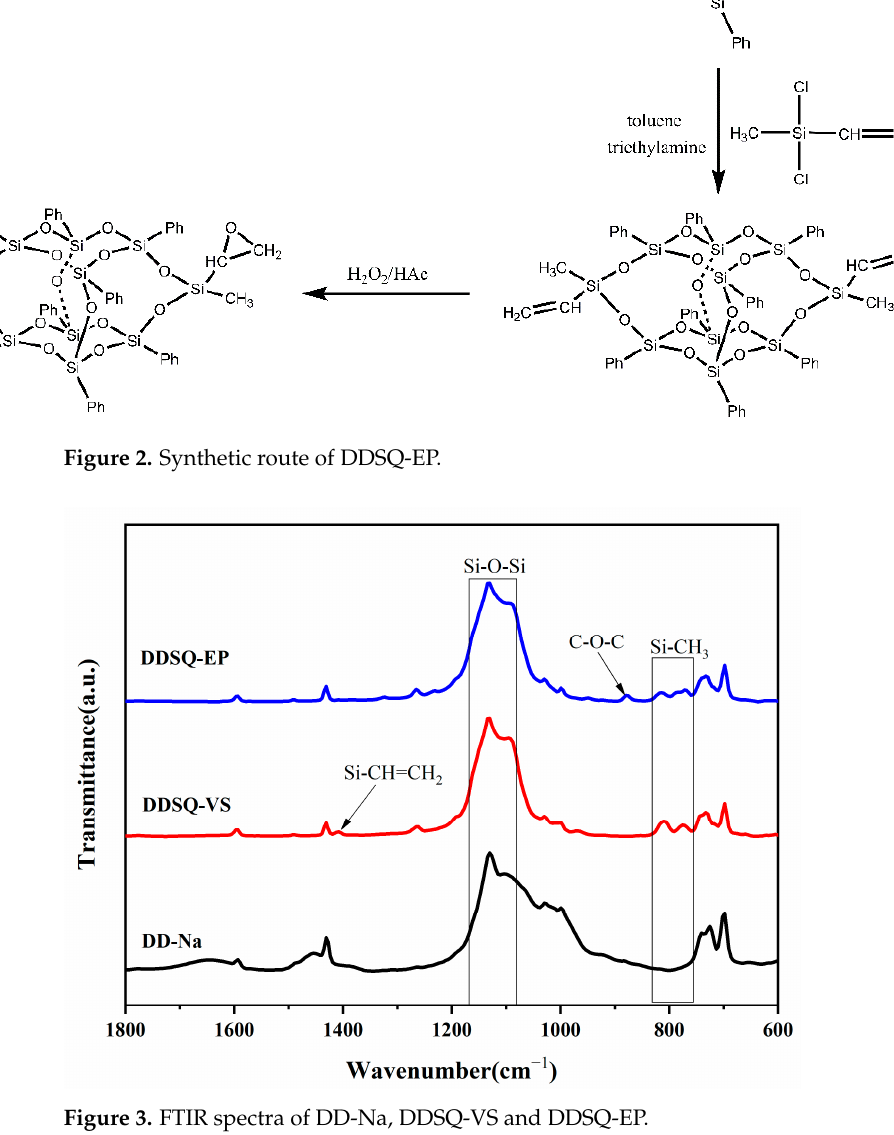
Figure 3. FTIR spectra of DD-Na, DDSQ-VS and DDSQ-EP.